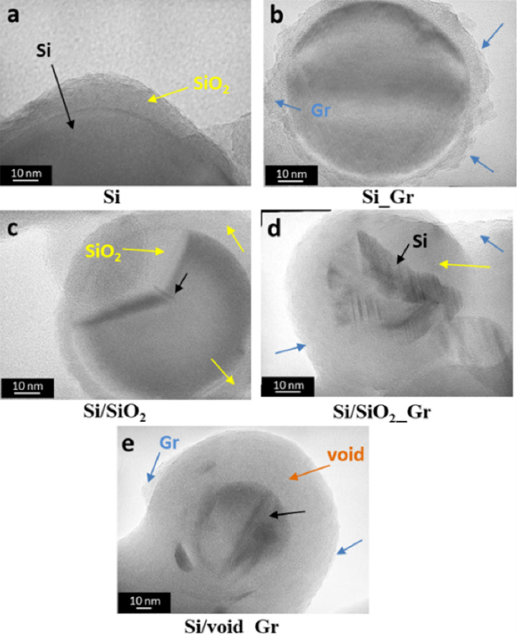
Figure 3. High Resolution TEM images of selected samples listed in Table 1, of ( a ) Si, ( b ) Si_Gr, ( c ) Si/SiO 2 , ( d ) Si/SiO 2 _Gr, and ( e ) Si/void_Gr powders. Black arrows: silicon, yellow arrows: SiO 2 , blue arrows: graphene layer, and orange arrow: void.